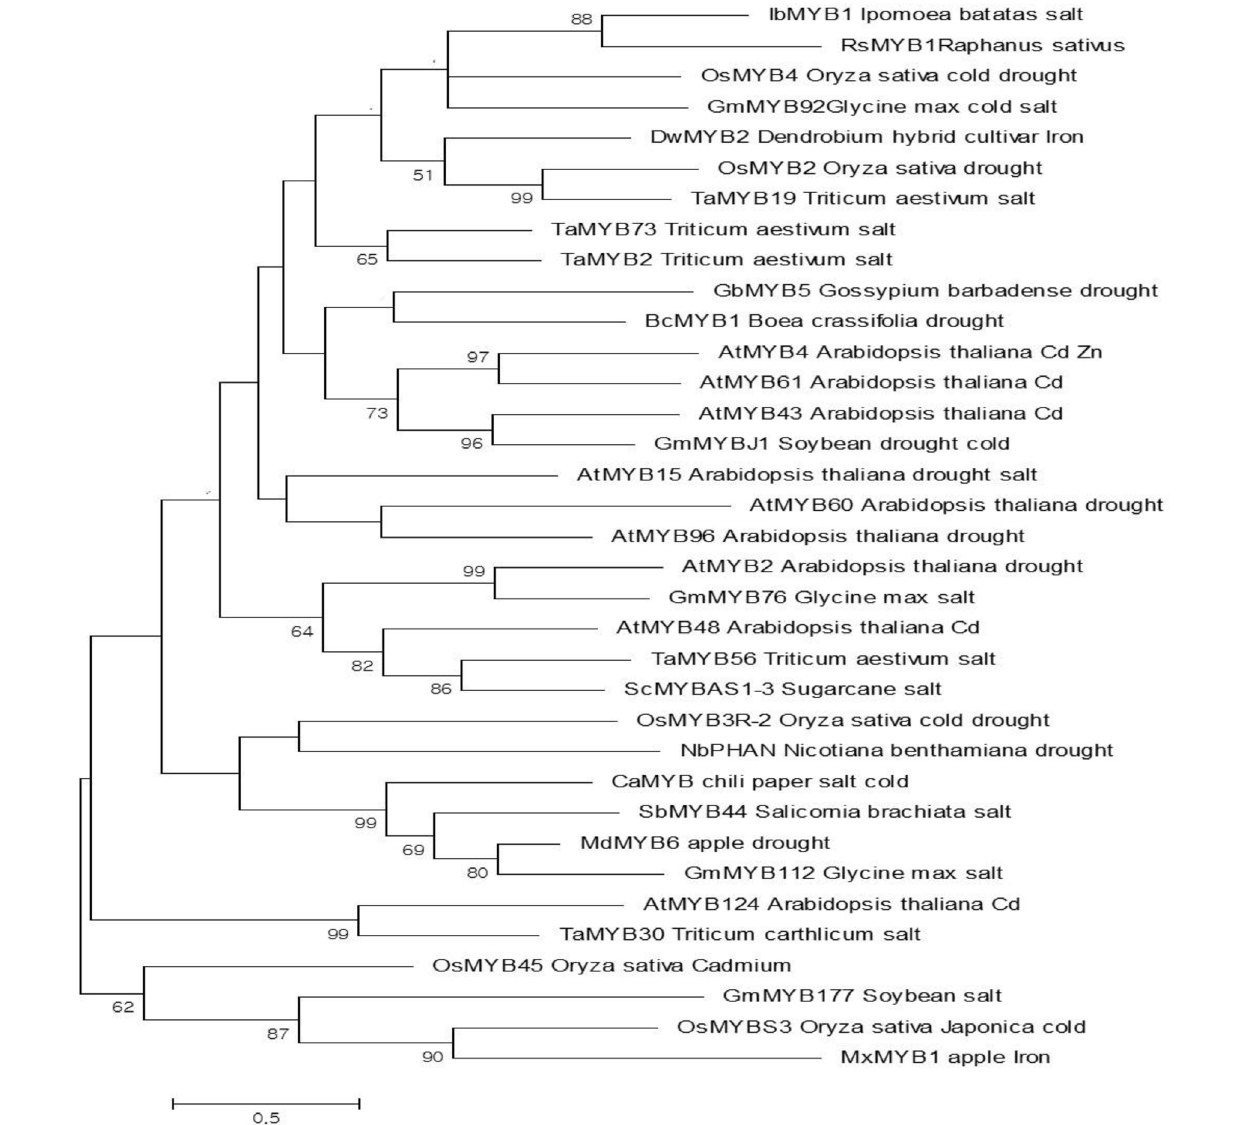
FIGURE 2 | Phylogenetic relationships of the RsMYB1 transcription factor (TF) with other MYB TFs that confer tolerance to various abiotic stresses. The evolutionary history was inferred by using the maximum likelihood method based on the Poisson correction model [1]. The tree with the highest log likelihood (–4439.60) is shown. Initial tree(s) for the heuristic search were obtained automatically by applying neighbor-joining and BioNJ algorithms to a matrix of pairwise distances estimated using a JTT model and then selecting the topology with superior log likelihood value. The tree is drawn to scale, with branch lengths measured in the number of substitutions per site. The analysis involved 35 amino acid sequences. All positions containing gaps and missing data were eliminated. There were 55 positions in the final dataset. Evolutionary analyses were conducted in MEGA7